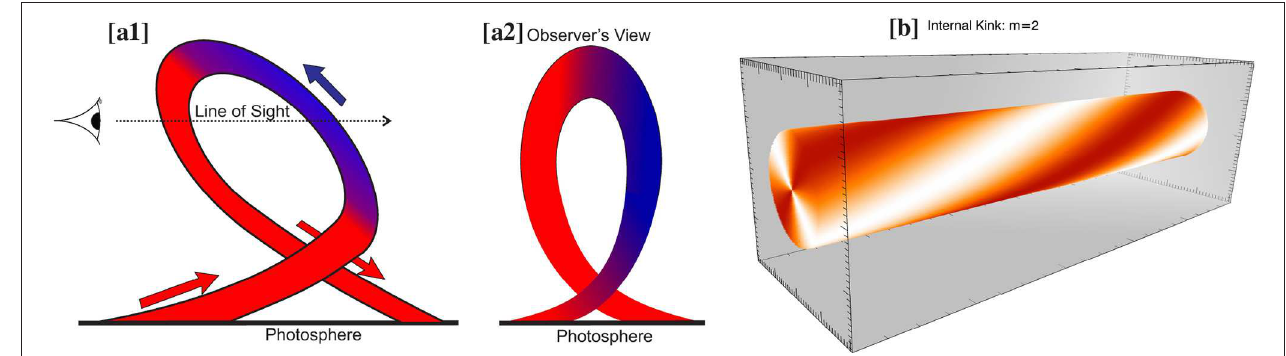
FIGURE 6 | Inferences on the magnetic structure of the prominence bubble as revealed by mass motions. (a1,a2) Schematic representation of a kinked flux-rope as the magnetic field configuration of the bubble, drawn from two perspectives. Material flowing toward (away from) the observer is denoted in blue (red) color. (b) Internal kink instability in a cylindrical flux-rope corresponding to mode (m) =